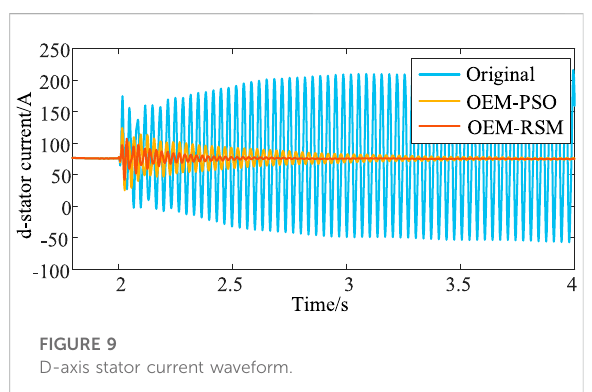
FIGURE 9 D-axis stator current